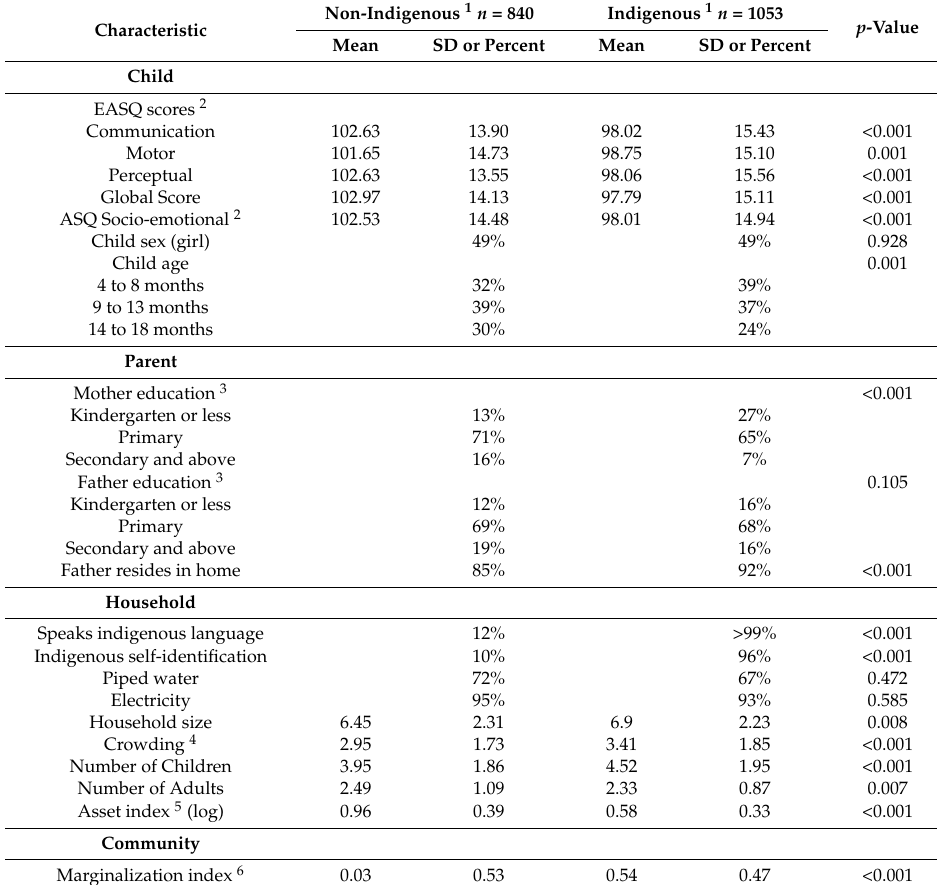
Table 1. Characteristics of sample ( n =